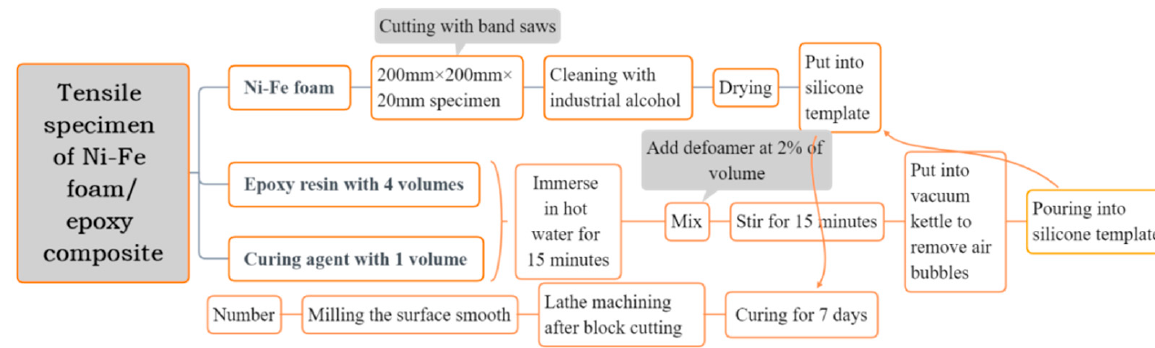
Figure 6. Flowchart of specimen processing.